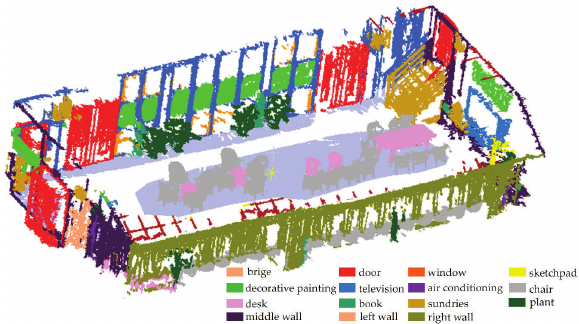
Figure 12. The semantic segmentation result of the test 3D point